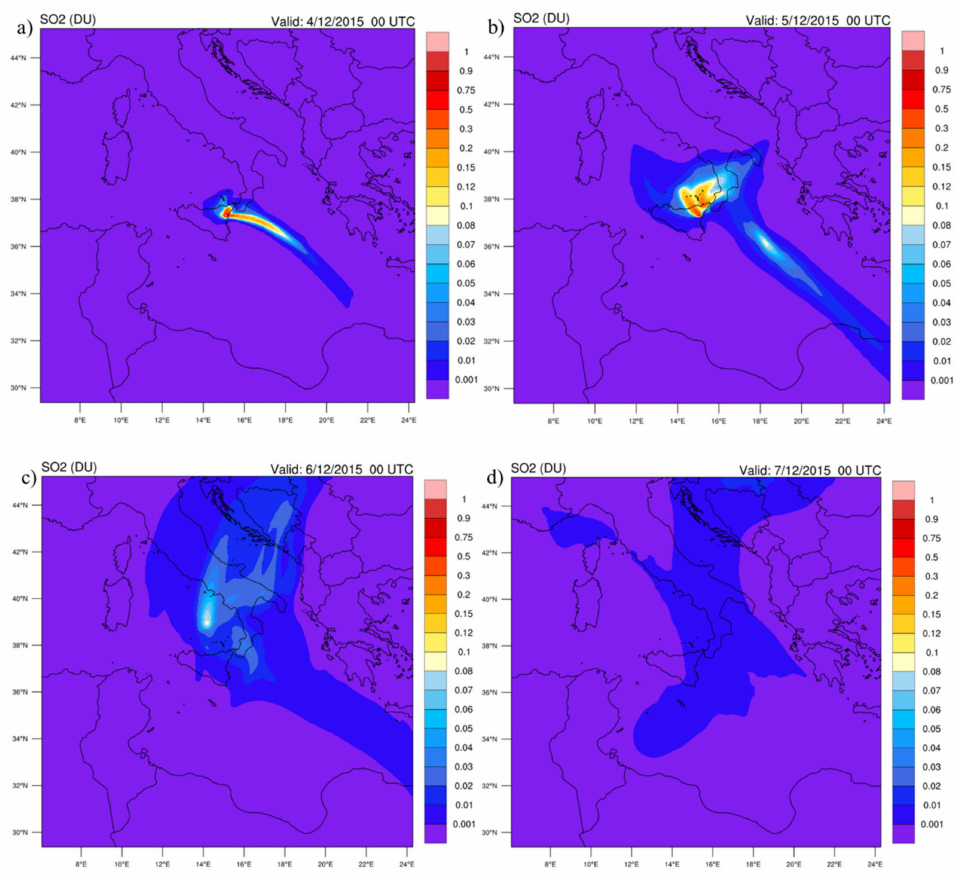
Figure 7. Sequence of images illustrating the distribution of sulfur dioxide (SO 2 ), obtained from simulations with the WRF–Chem model and checked on four days: ( a ) December 4th, ( b ) December 5th, ( c ) December 6th, and ( d ) December 7th. The legend is expressed in Dobson